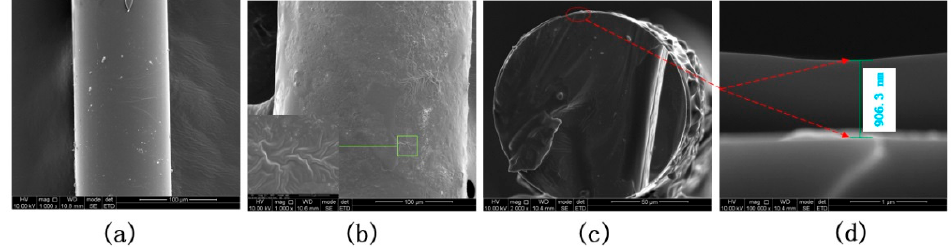
Figure 3. SEM images of the coated LPFG. ( a ) Fiber coated with pure PVA film; ( b ) fiber coated with PEG/PVA composite film; ( c ) cross-section of the coated LPFG; ( d ) film thickness of the coated film.